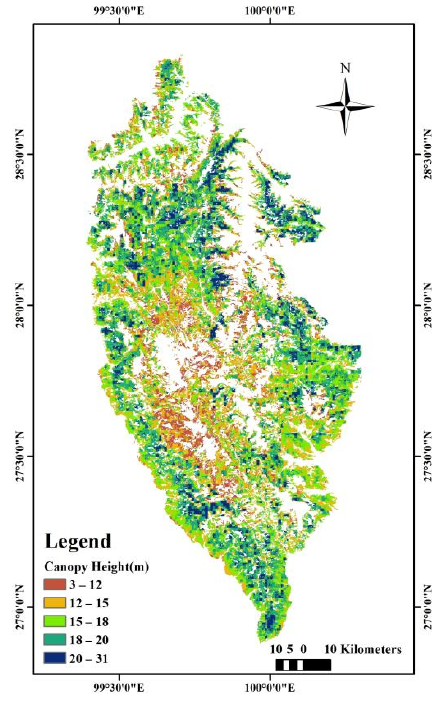
Figure 7. Forest canopy height mapping in Shangri-La City.